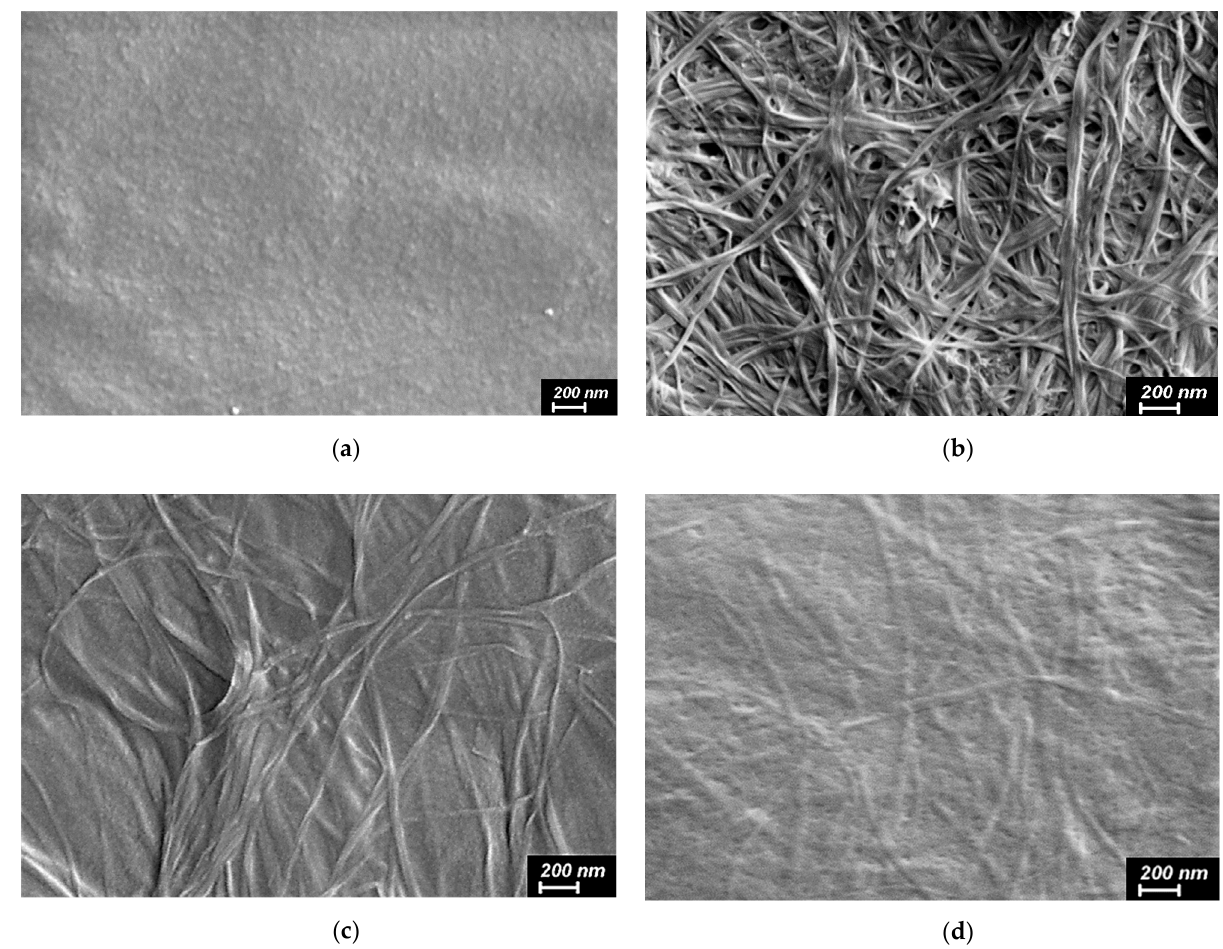
Figure 6. Scanning electron microscopy (SEM) images of the surfaces of the CS film ( a ), dried dispersion of BCd ( b ), the CS(80)-BC(20) ( c ) and BCd-CS-CeONP(8) ( d ) films.